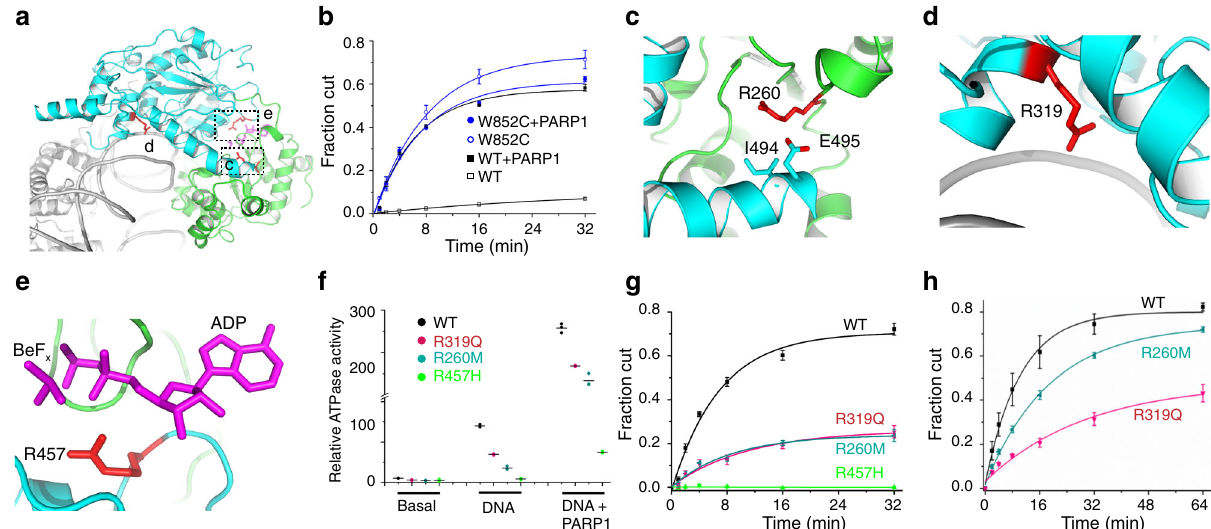
Fig. 5 Dysregulation of ALC1 by mutations found in cancer patients. a Map of cancer-associated mutations of ALC1 at the bioactive interfaces. Boxed regions are enlarged and analyzed in ( c – e ). b Chromatin remodeling activities of WT and W852C mutant in the presence ( fi lled symbols) and absence (open symbols) of PARP1. Error bars indicate standard deviations for three independent measurements and the measure of center for the error bars is the mean value. c – e The mutations at Arg260, Arg319, and Arg457 map to the lobe 1-lobe 2 interface ( c ), the lobe 2-DNA-binding interface ( d ), and the catalytic interface for ATP hydrolysis ( e ), respectively. f ATPase activities of WT, R260M, R319Q, and R457H mutant ALC1. All data points are shown with lines indicating the means ( n = 3). g Chromatin remodeling activities performed at 37 °C in the presence of PARP1. h Chromatin remodeling activities at 25 °C. Error bars indicate standard deviations for three independent measurements and the measure of center for the error bars is the mean value. Fitting the data indicated the remodeling rate constants were ~0.1 and ~0.05 min − 1 for the WT and the R260M mutant, noticeably promote the reaction (Suppl. Fig. 9e). We noticed that